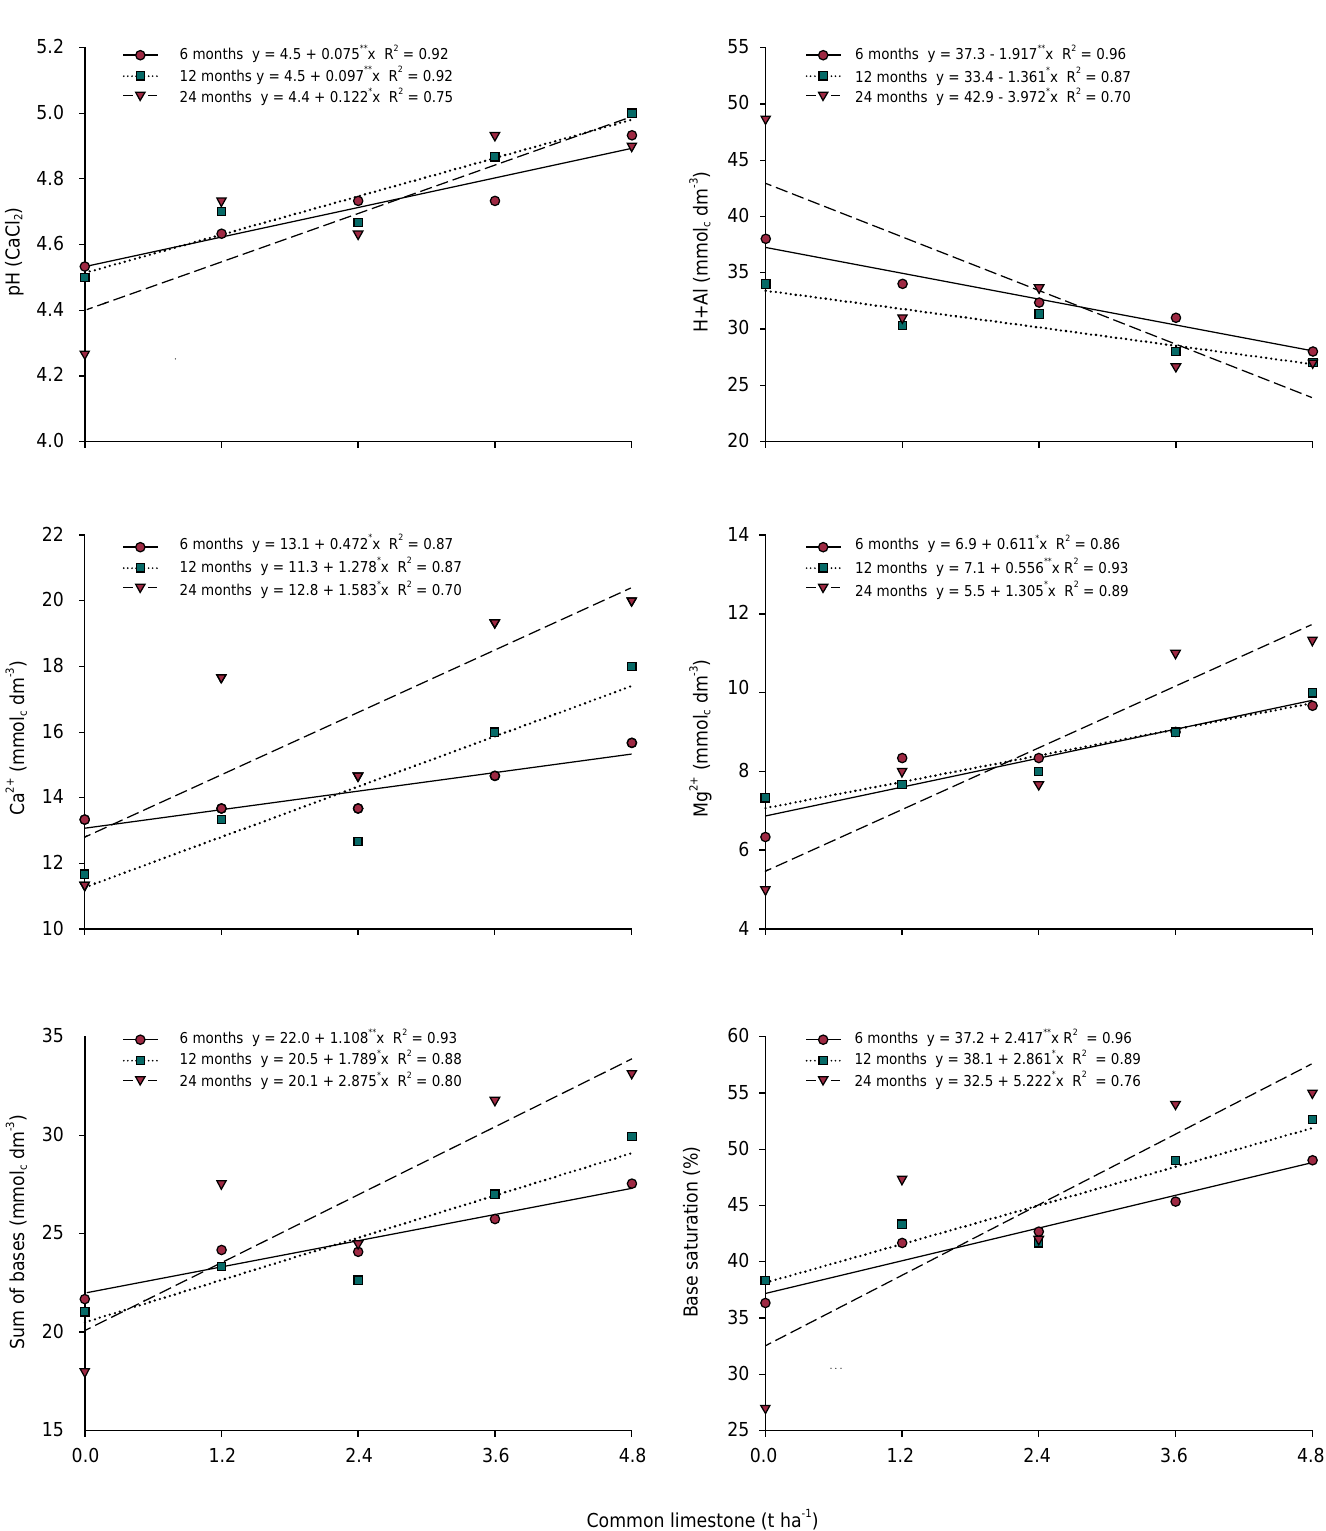
Figure 1. The pH value, potential acidity, Ca 2+ , Mg 2+ , sum of bases, and base saturation in the 0.00-0.10 m layer of an Argissolo Vermelho Amarelo [Ultisols (Soil Survey Staff, 2014)] in response to the rates of common limestone applied, without incorporation. The dots represent the averages of three replicates. ** and * indicate significance at 1 and 5 % probability,